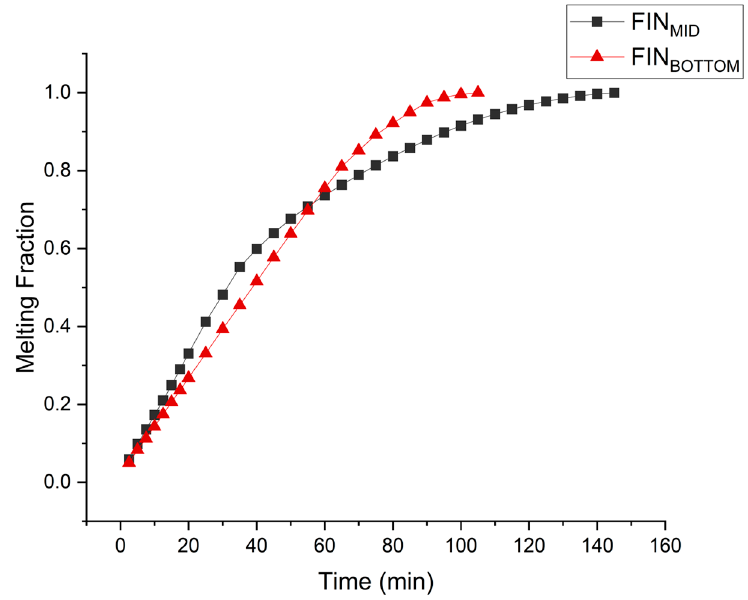
Figure 6. Numerical results comparison for fins placed at the mid and bottom positions.